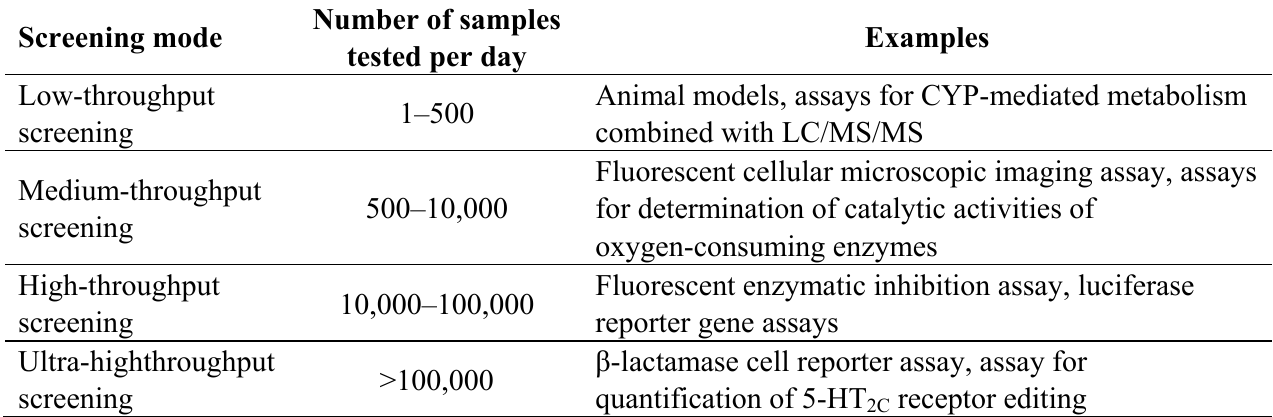
Table 2. Types of screening